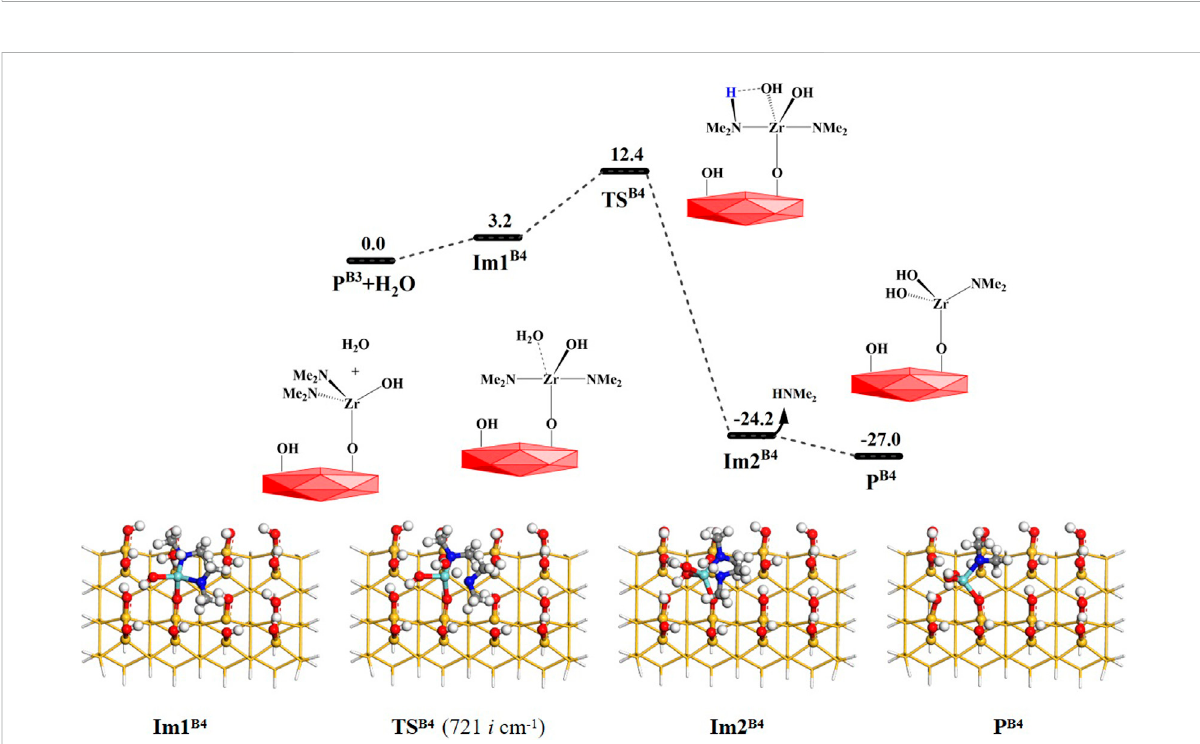
FIGURE 8 Gibbs free energy ( Δ G , kcal/mol) pro fi les of the B4 section of the H 2 O reaction with the aminated surface.